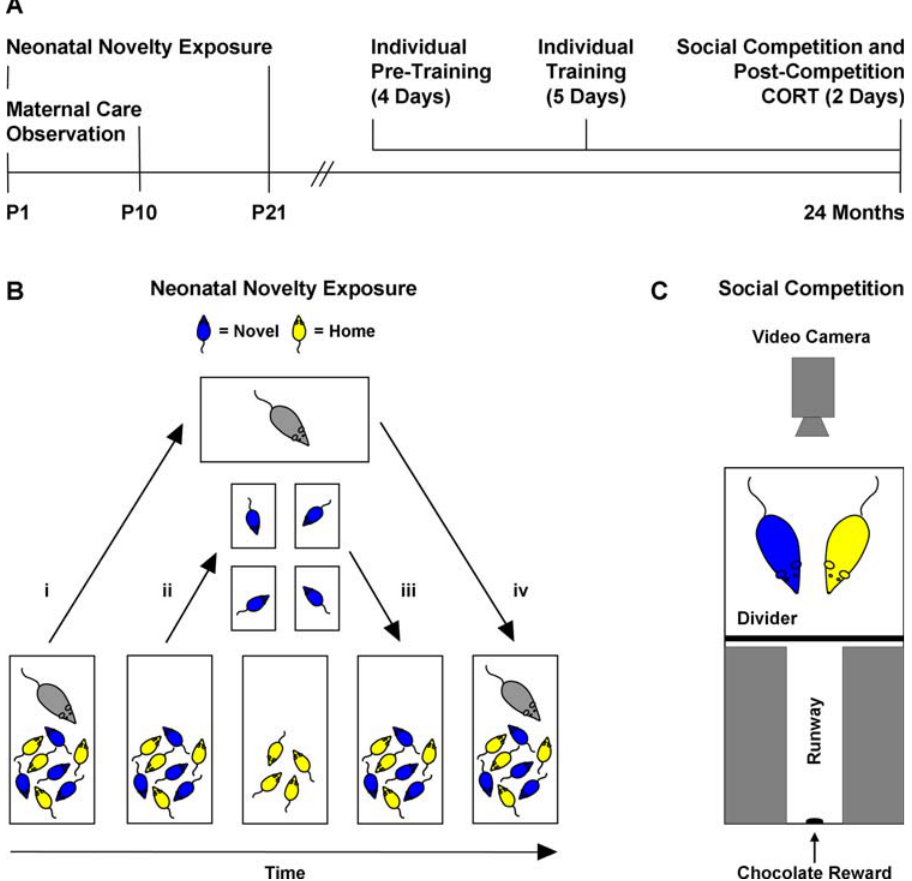
Figure 1. Experimental methods. A. Timeline. B . Sequential steps in carrying out the within-litter neonatal novelty exposure procedure: (i) Dam is removed from the home cage; (ii) Novel pups are transferred to individual non-home cages and yoked Home pups receive a matching amount of experimenter contact; (iii) After 3 min in the non-home cages, Novel pups are returned to the home cage in which the Home pups remain; (iv) Dam is returned to the home cage. C. Apparatus used to assess rats’ ability to compete against a conspecific for exclusive access to chocolate rewards. Note that the runway was sufficiently narrow as to allow only one rat at a time to fully enter.